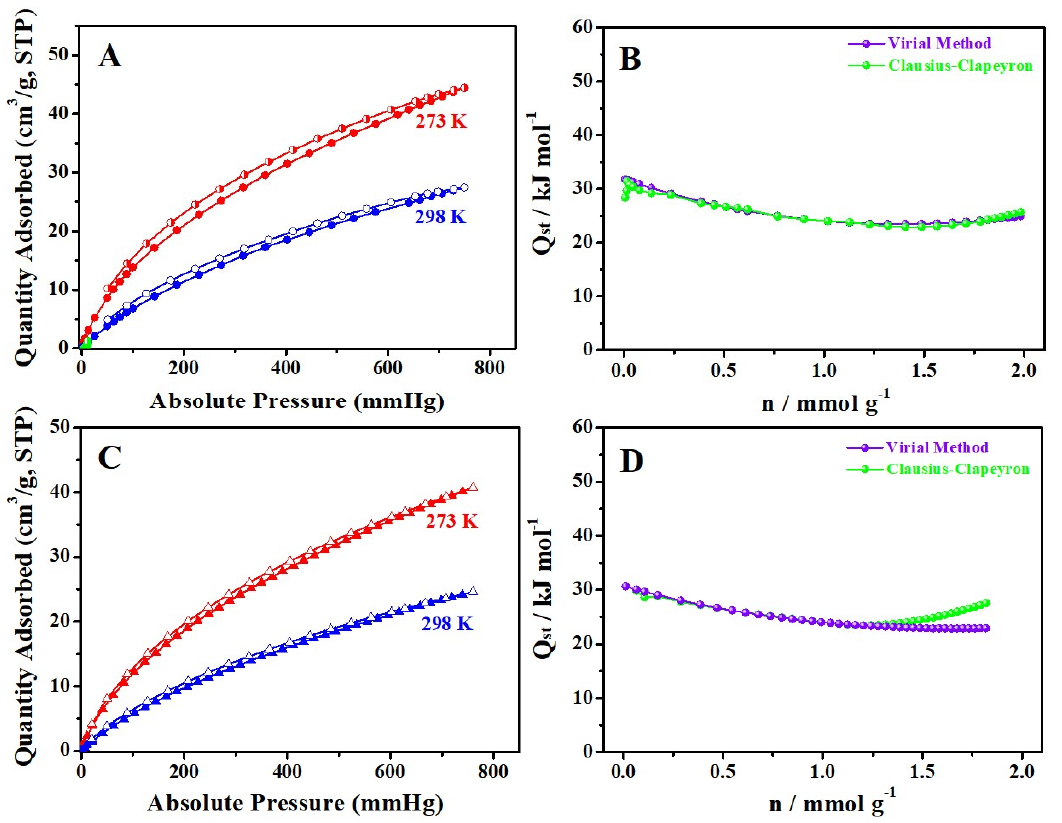
Figure 4. CO 2 sorption isotherms ( A , C ) and the corresponding Qst ( B , D ) of POP-PBC ( A , B ) and POP-PBH ( C , D ) measured at different temperatures.